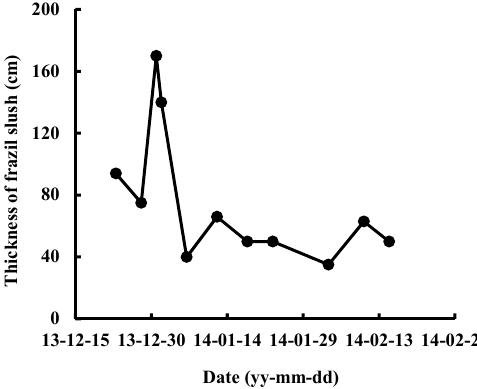
Figure 6. Thickness of frazil slush under the ice cover at Site B. section image was photographed under normal light, and the ice gas content was calculated using MATLAB software. Vertical density profiles and ice core gas contents are shown in Figure 7; it is noteworthy that frazil ice from Site B has a higher gas content than the pure thermal growth ice that contains intermittent frazil ice from Site A. Results show that the gas content of the frazil ice layer at core Site A is about 1.3% larger than adjacent columnar ice layers. Ice density is also negatively correlated with gas content; the density at Site B was less than 900 kg/m 3 but increased with depth as gas content decreased.